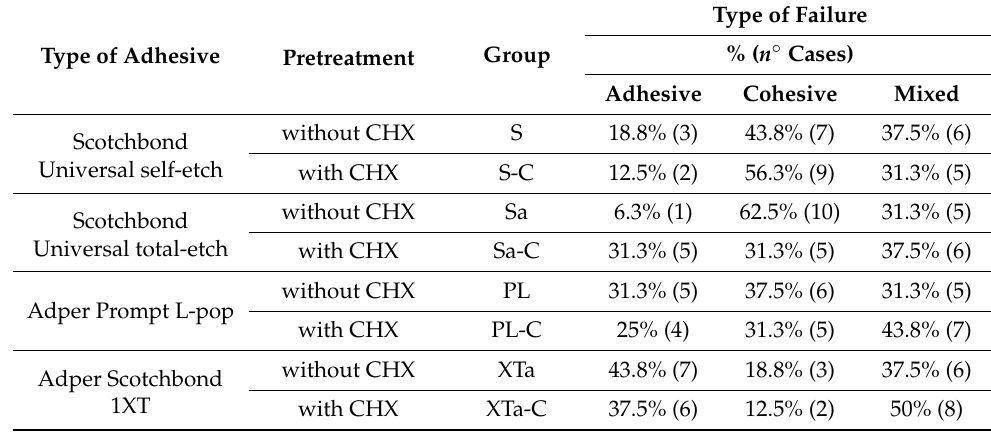
Table 5. Type of failure descriptive analysis by adhesive type and